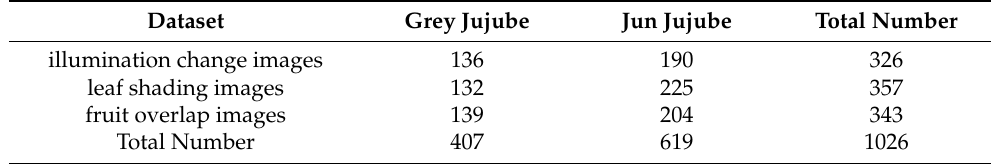
Table 1. Distribution of dataset of red jujubes.